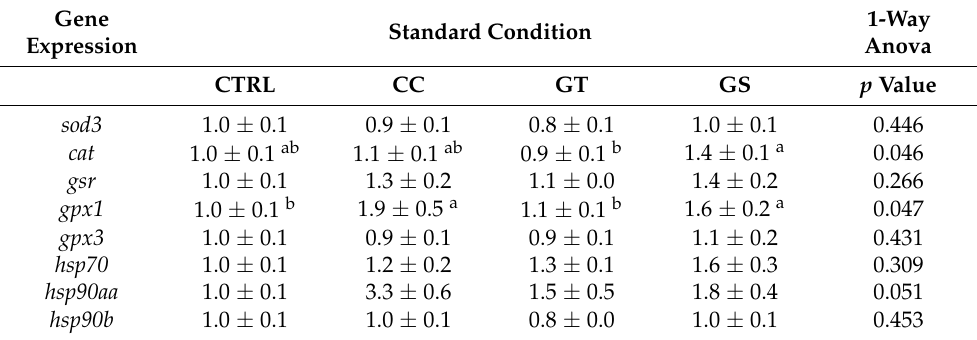
Table 2. Gene expression of oxidative and cellular stress-related biomarkers in 70 DAH Senegalese